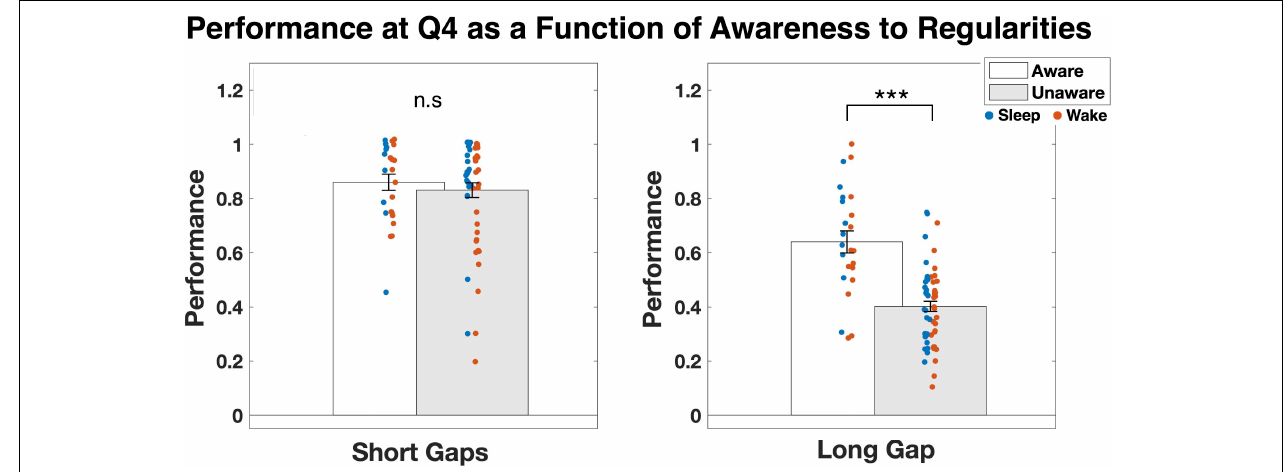
FIGURE 4 | Average performance in quartile 4 for participants who became aware of the hidden regularities compared to participants who did not become aware of the regularities. Results are presented separately for the shorter gaps (0, 1) and the longer gap (2). Individual values for each participant are presented as colorful dots, separately for the Sleep and Wake groups. A small jitter was added to the dots to allow easier visual separation. *** p <